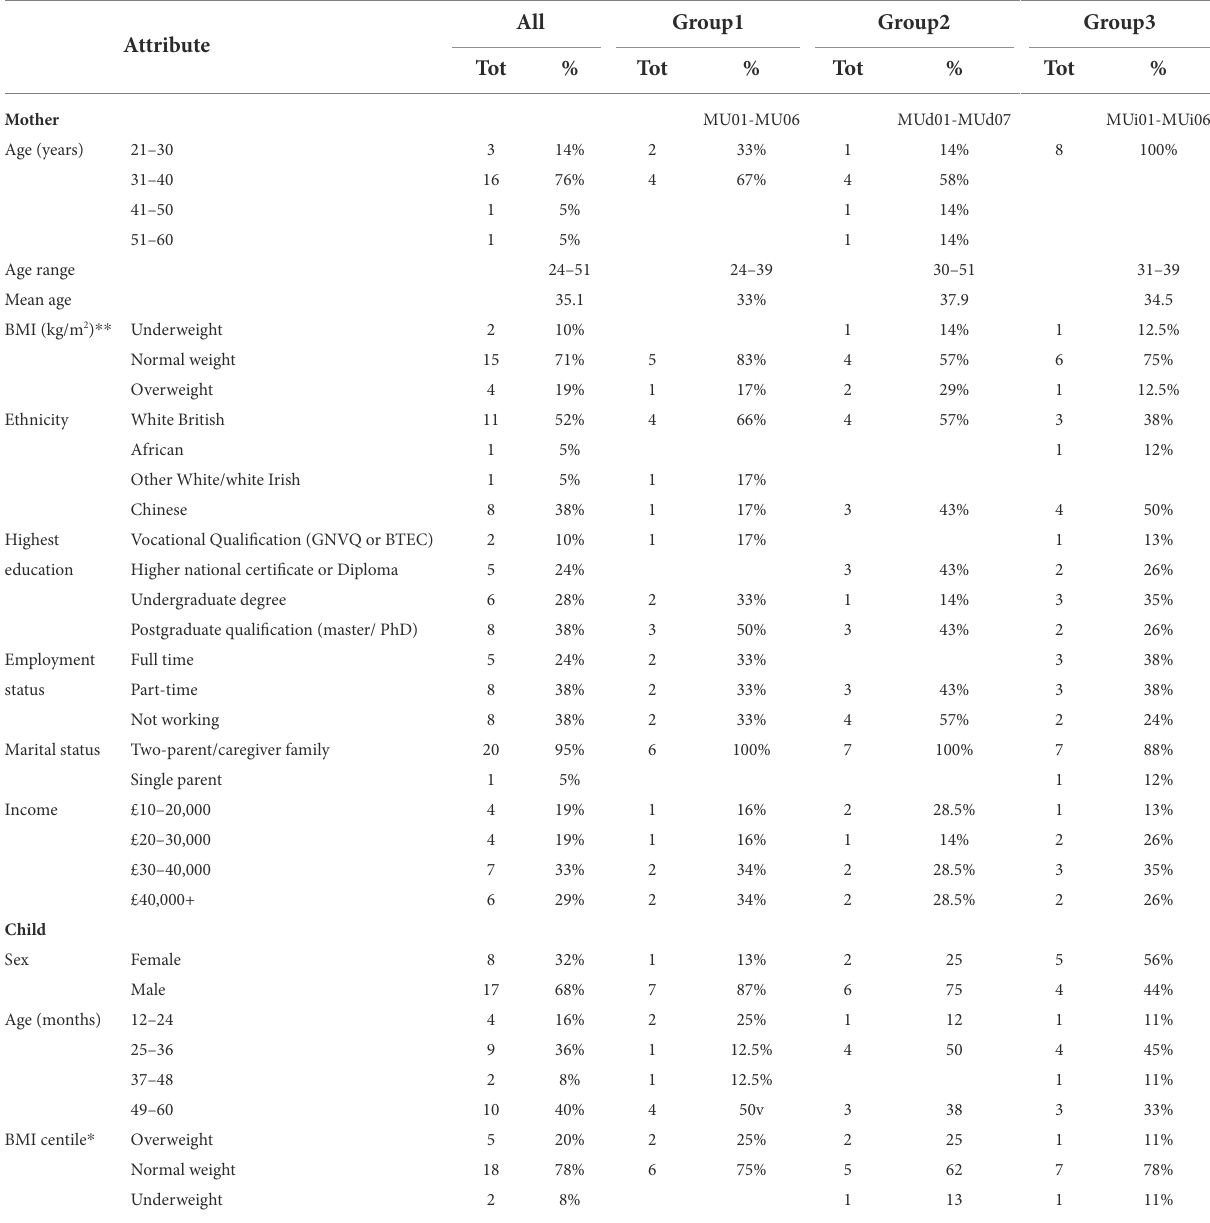
TABLE 2 Participant